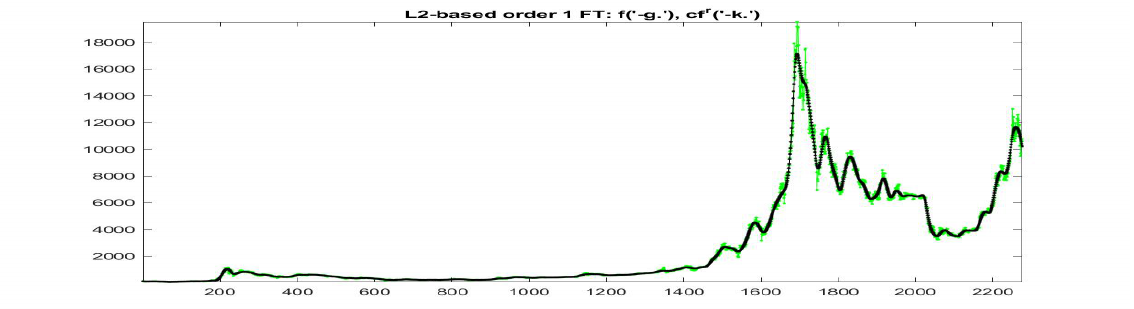
( t ) for Bitcoin series. Here, q = 1 and the j c , ( P b , A , r )